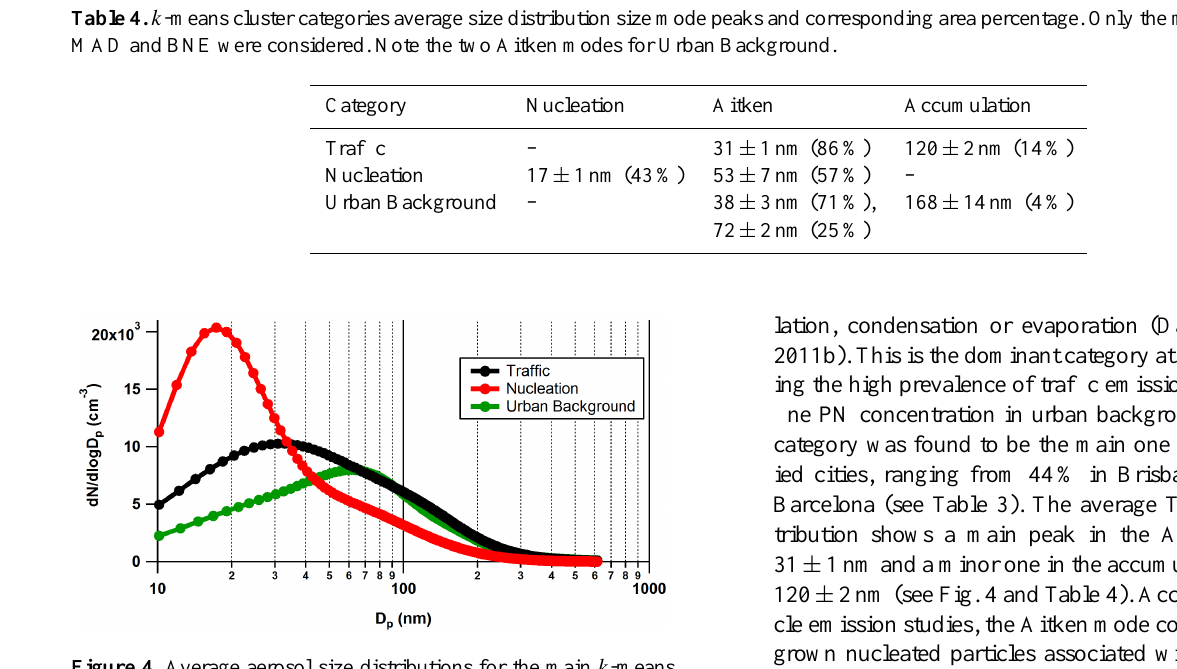
Figure 4. Average aerosol size distributions for the main k -means cluster category: Traffic, Nucleation and Urban Background. Only the main cities BCN, MAD and BNE were